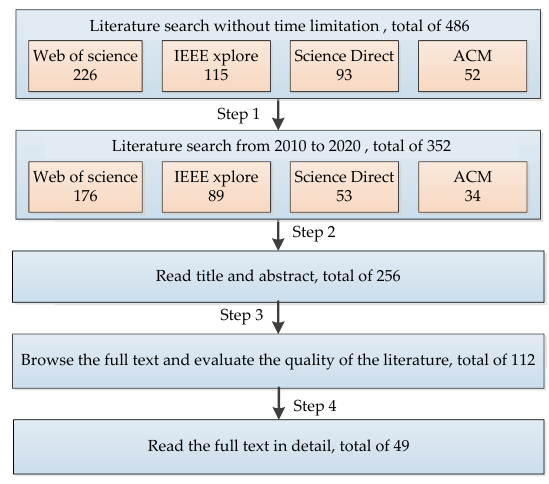
Figure 2. The flow chart of the search strategy.